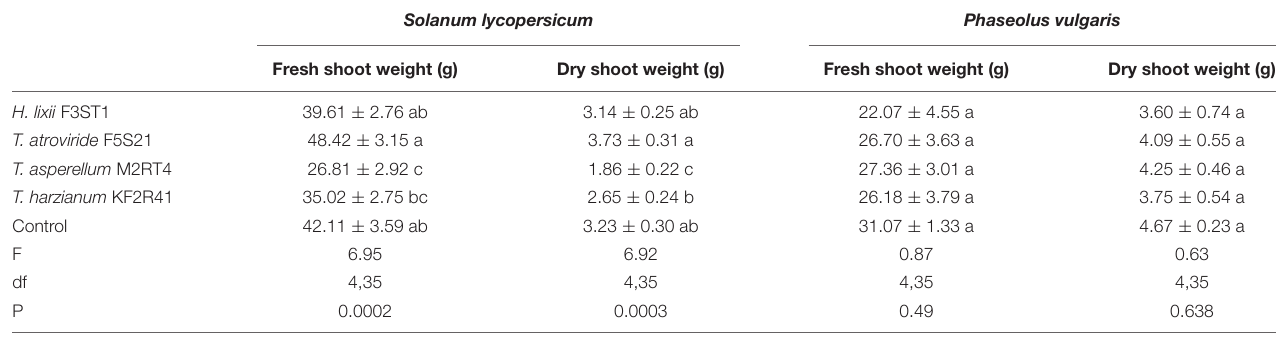
TABLE 3 | The effect of seed inoculation of H. lixii F3ST1, T. asperellum M2RT4, T. atroviride F5S21, and T. harzianum KF2R41 on the plant shoot biomass at 5 weeks post-inoculation.